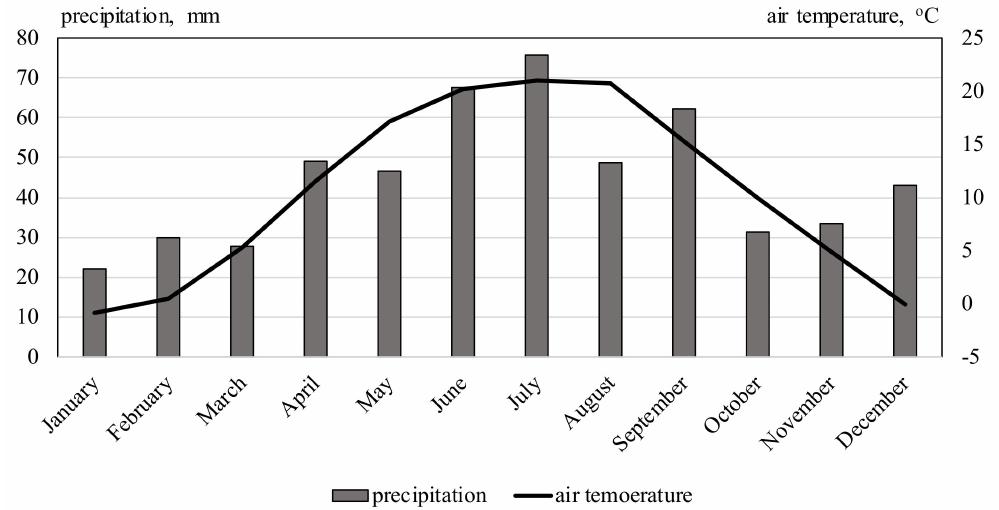
Figure 2. Average temperature and rainfall in the research station